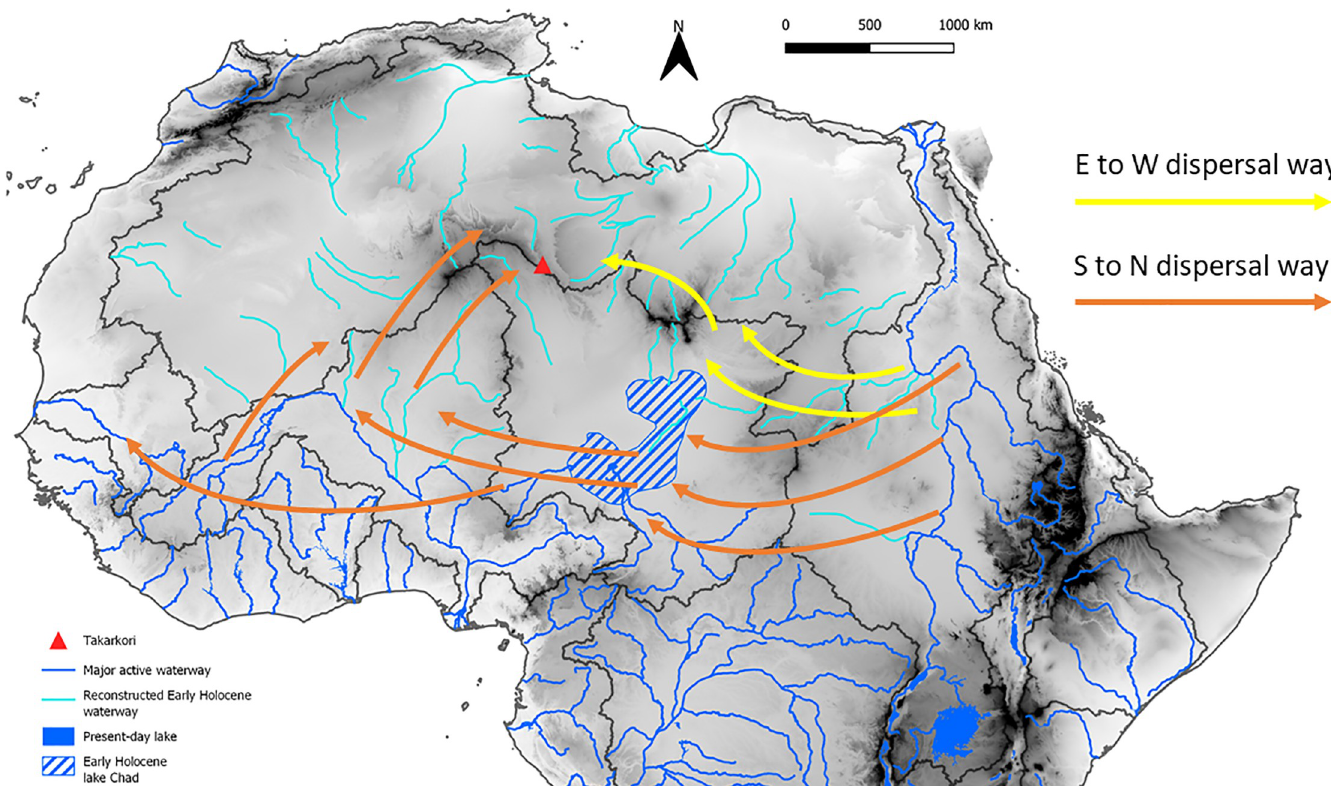
Fig 15. Possible colonization pathways of aquatic species to the central Sahara; detailed discussion is in the text.